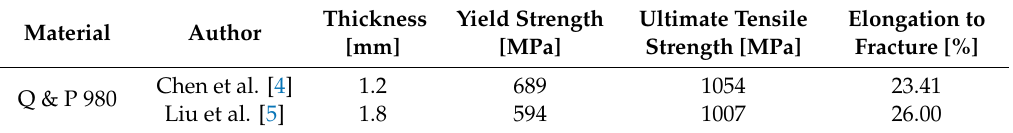
Table 1. Mechanical properties of Q & P 980 steel. Data from